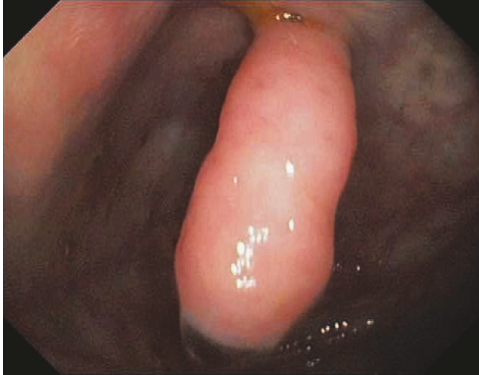
Figure 13: Endoscopic image of an inverted appendix appearing as a polypoid lesion at the cecal pole. The mucosal pattern is normal.